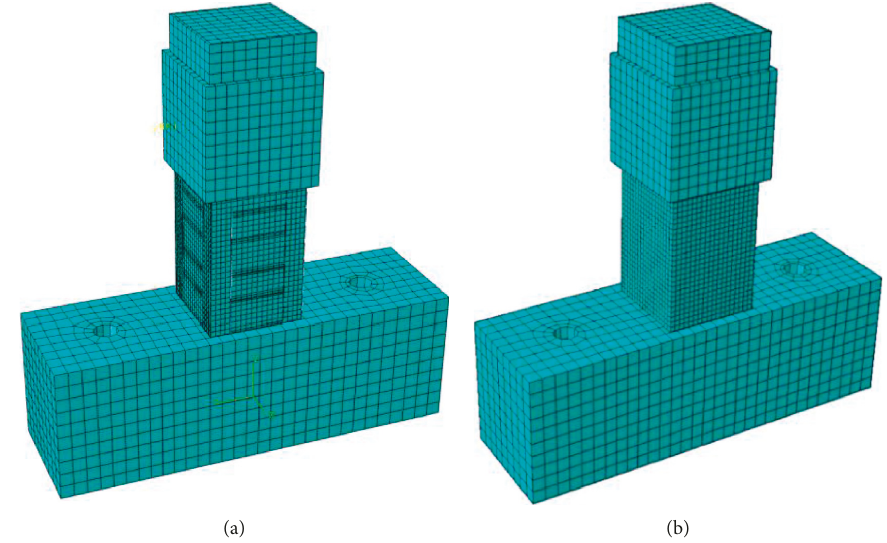
Figure 16: FE models of hysteretic analysis. (a) ISSCC column. (b) RC column.